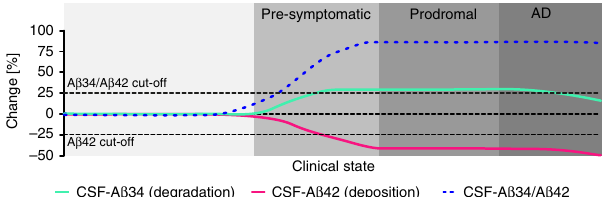
Fig. 9 Conceptual model of early changes in AD. Before a clinical diagnosis of Alzheimer ’ s disease (AD), decades of A β peptide deposition lead to plaque formation in pre-symptomatic and prodromal stages of the disease. Incorporating A β 34 (marker of enzymatic A β degradation) with measures of A β 42 (marker for cerebral A β deposition) could complement